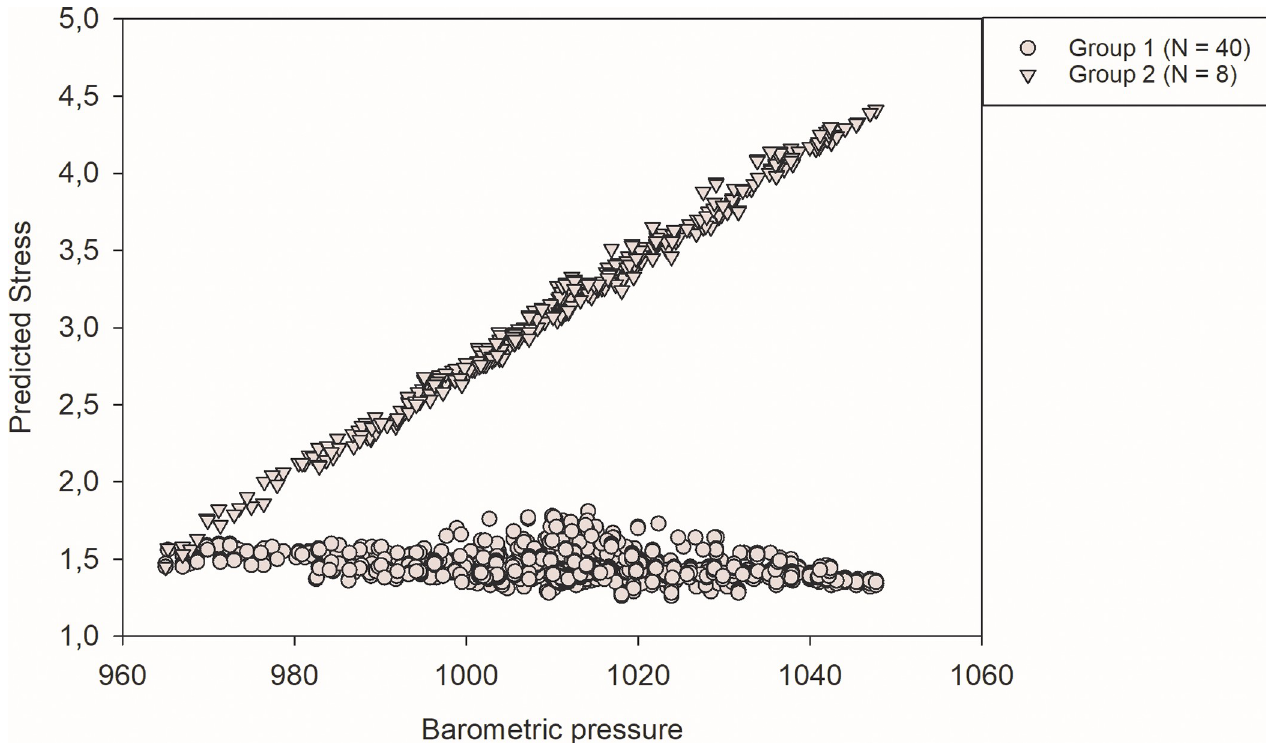
Fig 2. Group-difference in stress associated with barometric pressure. Barometric pressure shown in millibar. Stress was measured on a Numeric Rating Scale from 0–10. Group 1 is the majority of patients who reported lower pain concomitantly with an increase in barometric pressure, whereas group 2 is the sub-group of patients reporting increased pain concomitantly with increased barometric pressure.